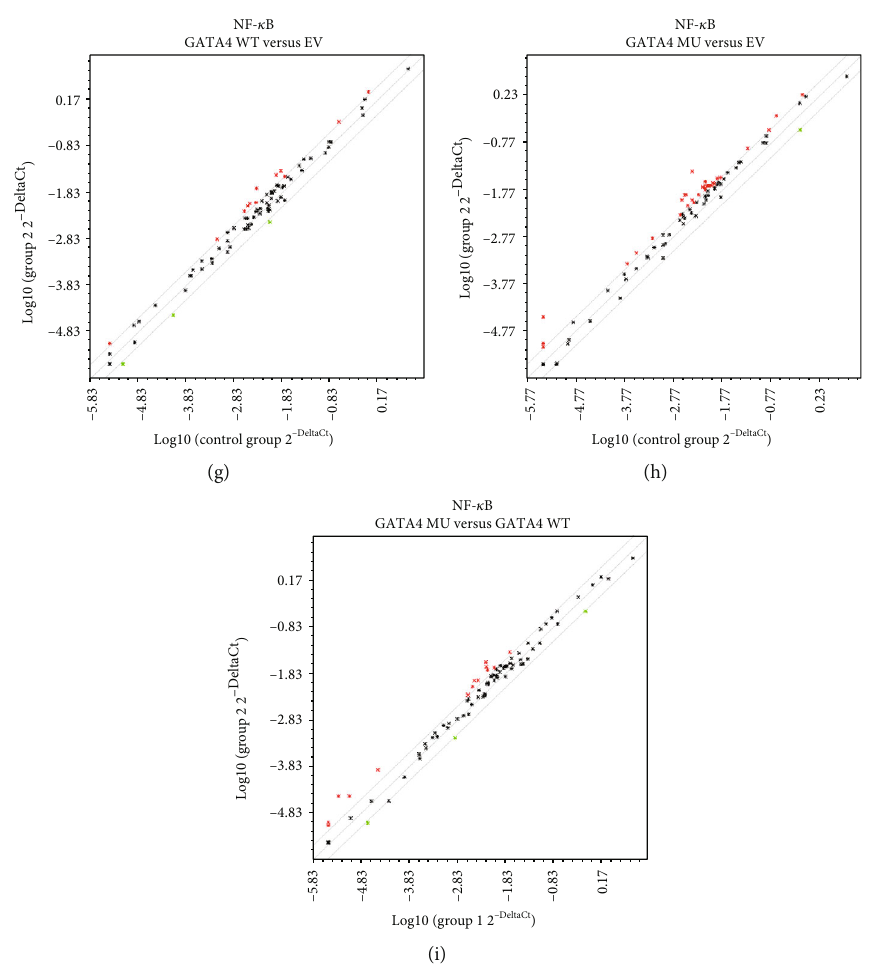
Figure 4: The scatter plots of PCR array results. (a – c) Rat atherosclerosis; (d – f) rat in fl ammatory cytokines and receptors; (g – i) rat NF- κ B. Fold change ≥ 2 was taken as the threshold value. (a, d, and g) WT versus EV; (b, e, and h) MU versus EV; (c, f, and i) MU versus